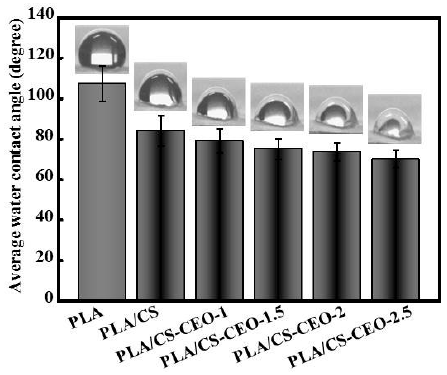
Figure 5. Photographs of water droplets from which average water contact angles of PLA/CS-CEO electrospun fibers were measured; n = 5.